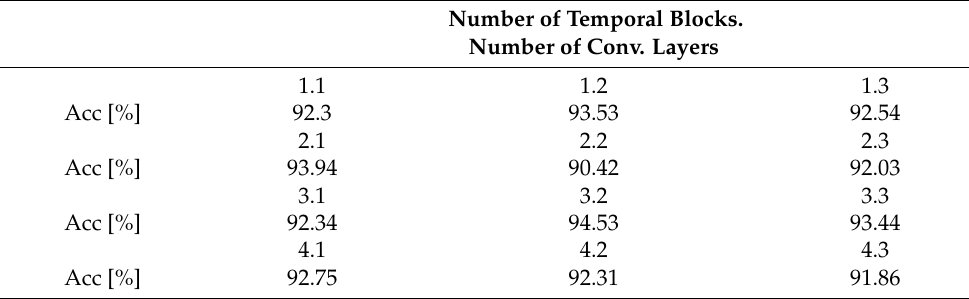
Table 4. Accuracy from ablation study of dilated TCN.